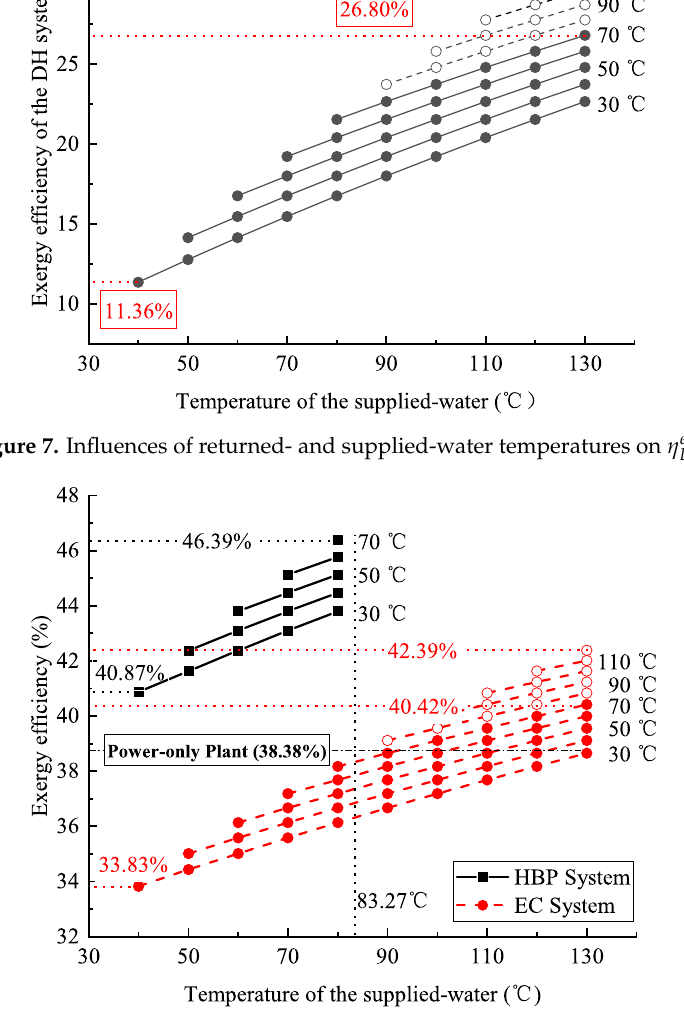
Figure 8. Influences of returned- and supplied-water temperatures on η ex